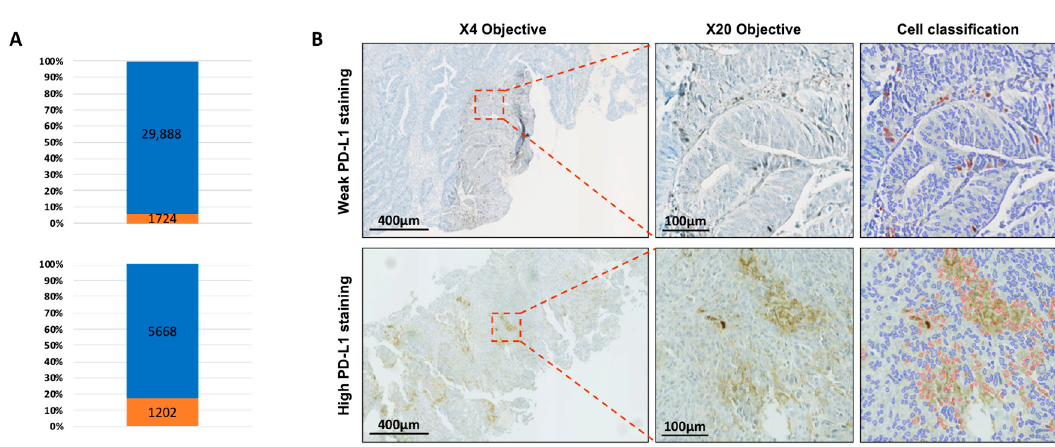
Figure 1. ( A ) Representative histograms of weak (top) and high (bottom) rates of PD-L1 stained cells. Positive cells number are shown in orange, negative cells number in blue. ( B ) Representative weak (top) and high PD-L1 stainings (bottom) at low magnification ((left) scale bar 400 µm) corresponding to patients in ( A ). Higher magnifications are displayed on the center part of the figure (scale bar is 100 µm). Positive cell detection (right) using QuPath (script available in the Supplementary Materials) has been automatically processed. Positive cells are red-outlined while negative cells are blue-outlined.